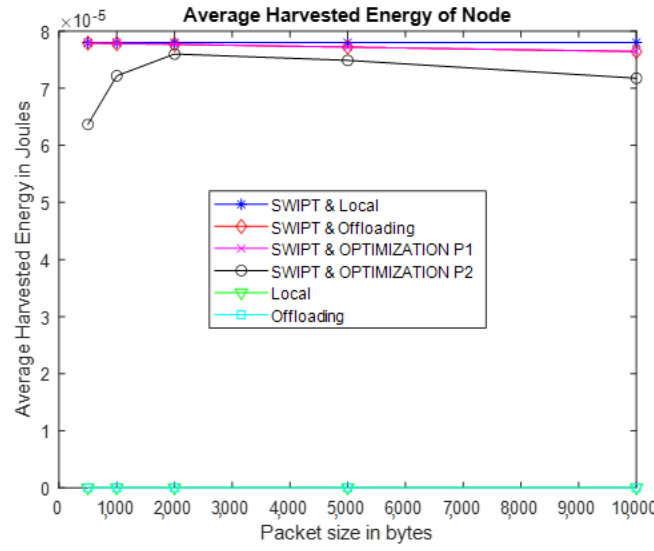
Figure 13. Average harvested energy of the end node with variable packet size.